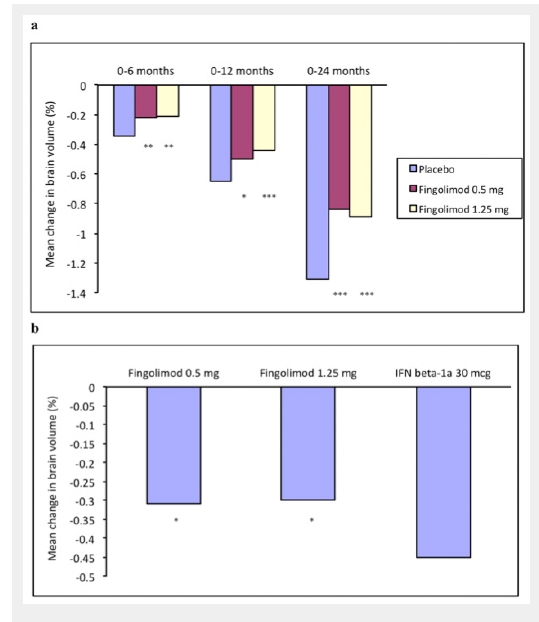
(a) Mean change in brain volume in patients with relapsing- remitting multiple sclerosis receiving oral treatment with fingolimod, 0.5 or 1.25 mg, or placebo once daily for 2 years in the FREEDOMS Study [11]. *,**,*** p ≤0.05, 0.01, 0.001, respectively, versus placebo (b) Mean change in brain volume over 1 year in relapsing-remitting multiple sclerosis patients receiving fingolimod, 0.5 or 1.25 mg daily or intramuscular IFNβ-1a 30 μg per week in the TRANSFORMS Study [12]. * p <0.001 versus